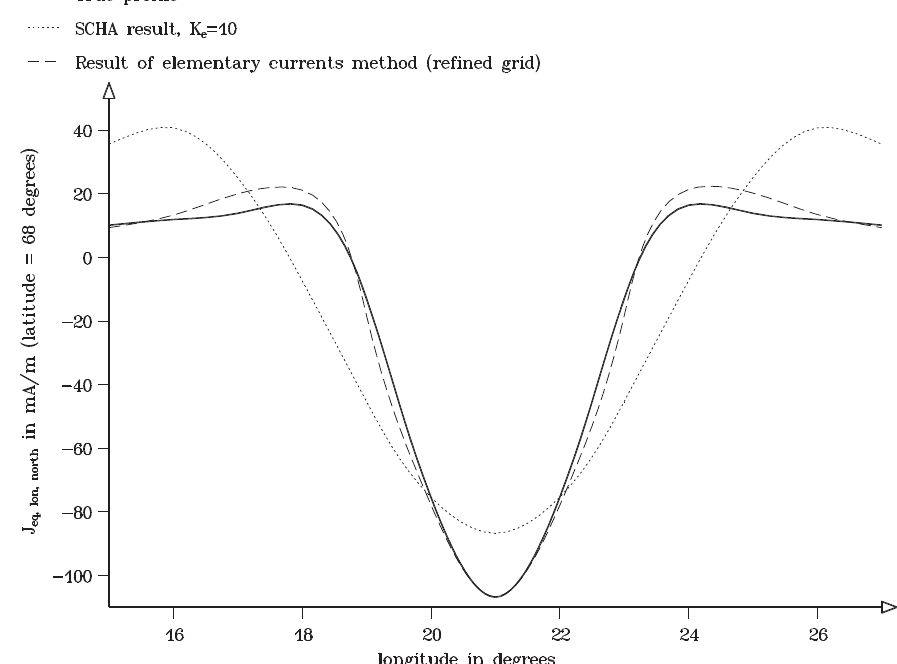
Fig. 3. Longitudinal profile of the north component of the ionospheric equivalent currents in the test model. Solid line: true profile; Dotted line: SCHA upward continuation result with up to 10th order basis functions; Broken line: SECS method upward continuation result. Reproduced from Fig. 6 of Amm and Viljanen